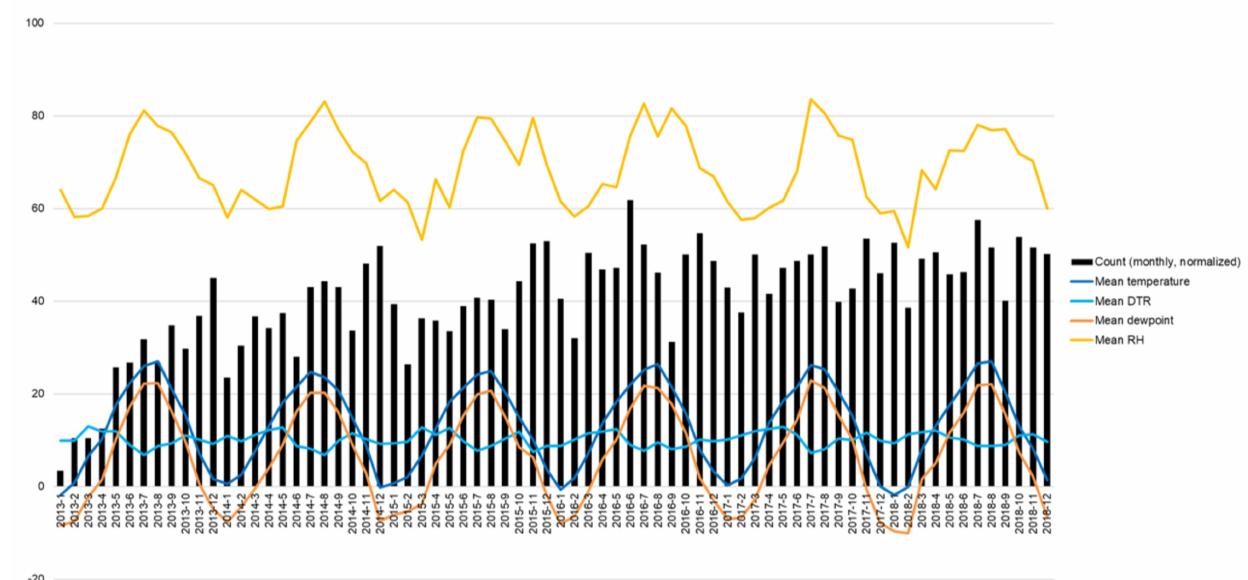
Figure 2. Diabetic foot amputation (normalized) and climate trend (January 2013 − December 2018). (Note) Monthly count of diabetic foot amputation normalized with standard deviation for the year. DTR: diurnal temperature range, difference between the daily maximum and minimum temperature ranges; RH: relative